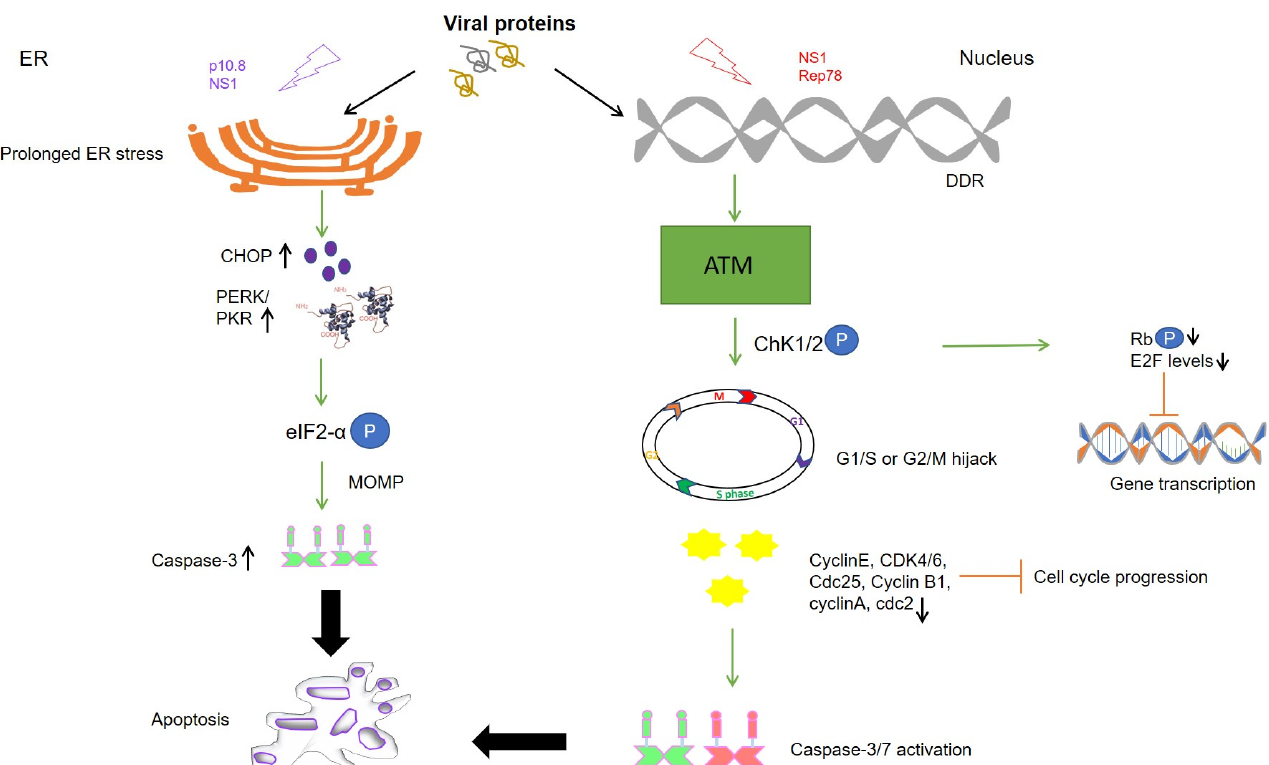
Figure 1. Schematic representation of different cell death pathways mediated by viral proteins. Levels of kinases are upregulated in cancer cells due to which phosphorylation and activation of viral protein residues (NS1 and p 10.8) lead to ER stress and DNA damage response (DDR) causing mitochondrial outer membrane permeabilization (MOMP), apoptosis, and cell death. Cell cycle arrest is mediated by activation of DDR (NS1) and downstream kinases like Ataxia telangiectasia mutated (ATM) and checkpoint kinases (Chk1/2). Cell cycle progression is inhibited at the G1/S or G2/M phase of the cell cycle as respective cyclins and CDKs are inactivated upon expression of the viral proteins mediated caspase activation (Rep78). At the same time, E2F inhibition is maintained by dephosphorylation of retinoblastoma protein (pRb) by Chk1/2, finally inhibiting the transcription of proto-oncogenes. Upward arrow ↑ —upregulation; downward arrow ↓ —downregulation; circled P in blue—phosphorylation.